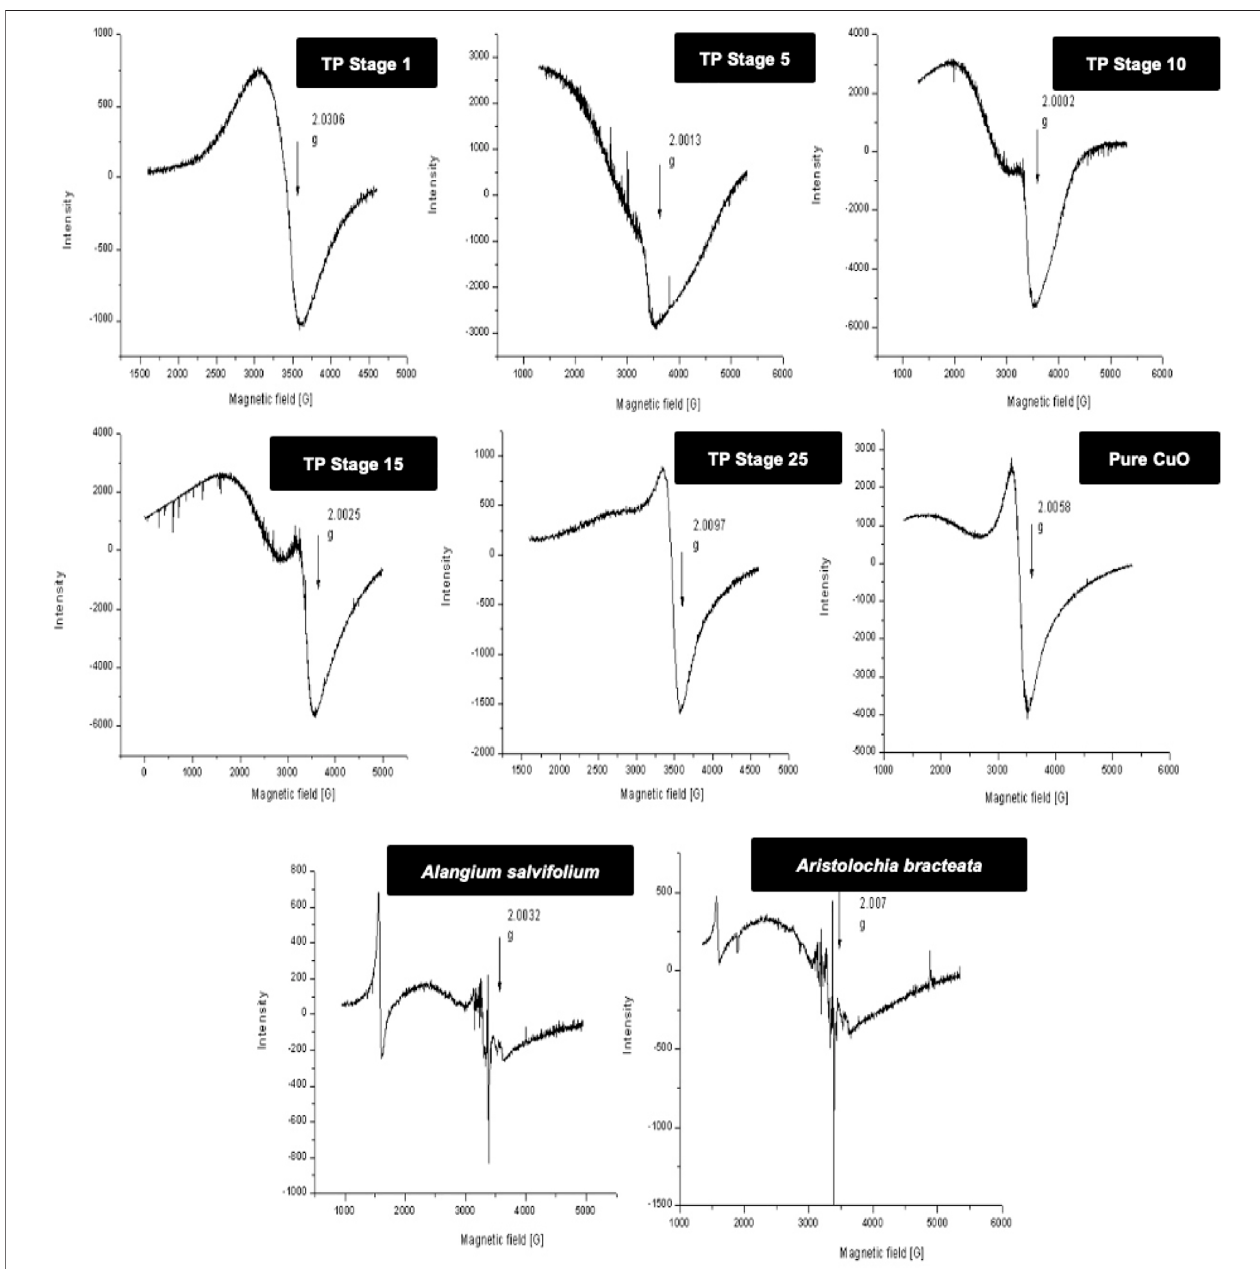
FIGURE4| Low-temperature(77 K)electronparamagneticresonance(EPR)spectraofvariousstagesThamiraparpampreparedbythetraditionalancientmethod in comparison to the laboratory method of TP preparation. (A) Stage-1 TP; (B) Stage-5 (C) Stage-10 TP (D) Stage-15 TP; (E) Stage-25 TP; (F) CuO (G) Alangium salviifolium; (H) Aristolochia